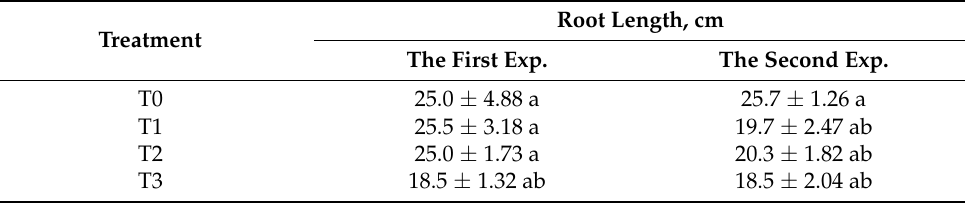
Table 3. Root length of P. oleracea species. Different letters within a column represent significant differences ( p ≤